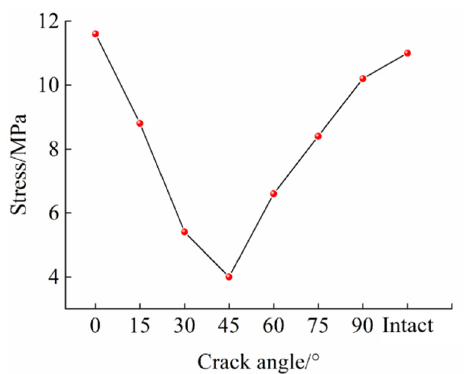
Figure 10. Acoustic emission evolution behaviors of coal–rock combined body.